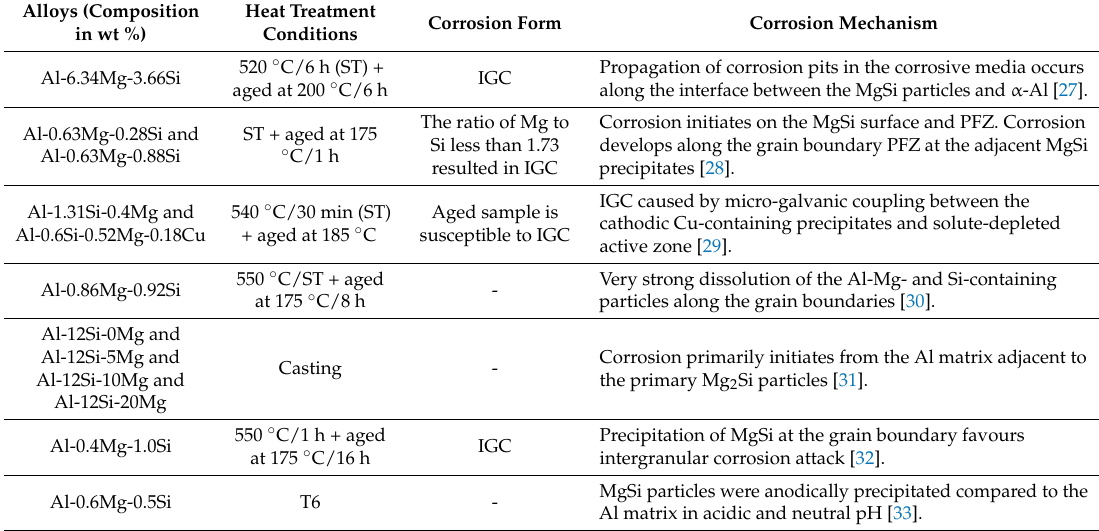
Table 1. Summary of the corrosion behaviours of Al-Mg-Si